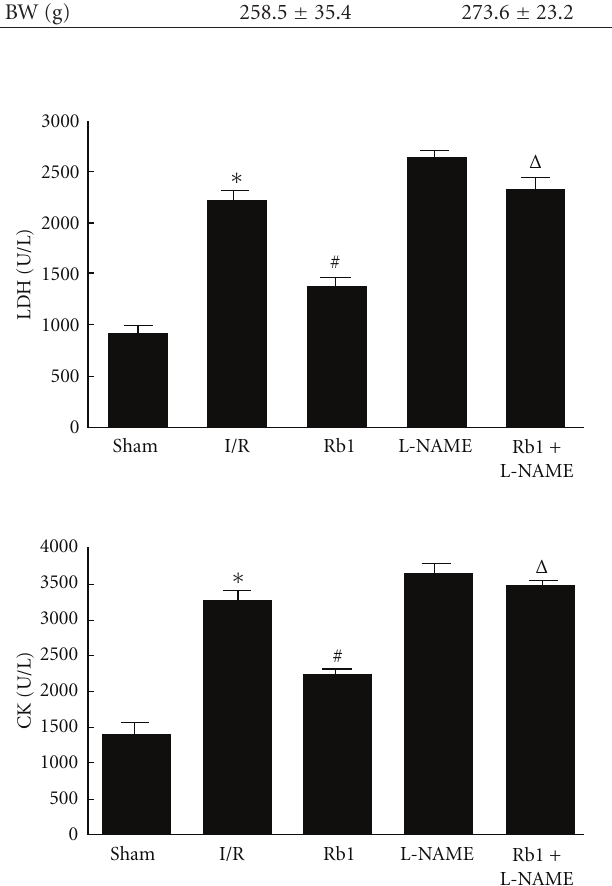
Figure 2: E ff ects of Rb1 with or without L-NAME pretreatment on plasma levels of CK, LDH after 30min of myocardial ischemia and 120 min of reperfusion. Results are expressed as mean ± SEM. ∗ P < 0 . 01 versus Sham group, # P < 0 . 01 versus I/R group, Δ P < 0 . 01 versus Rb1 group.